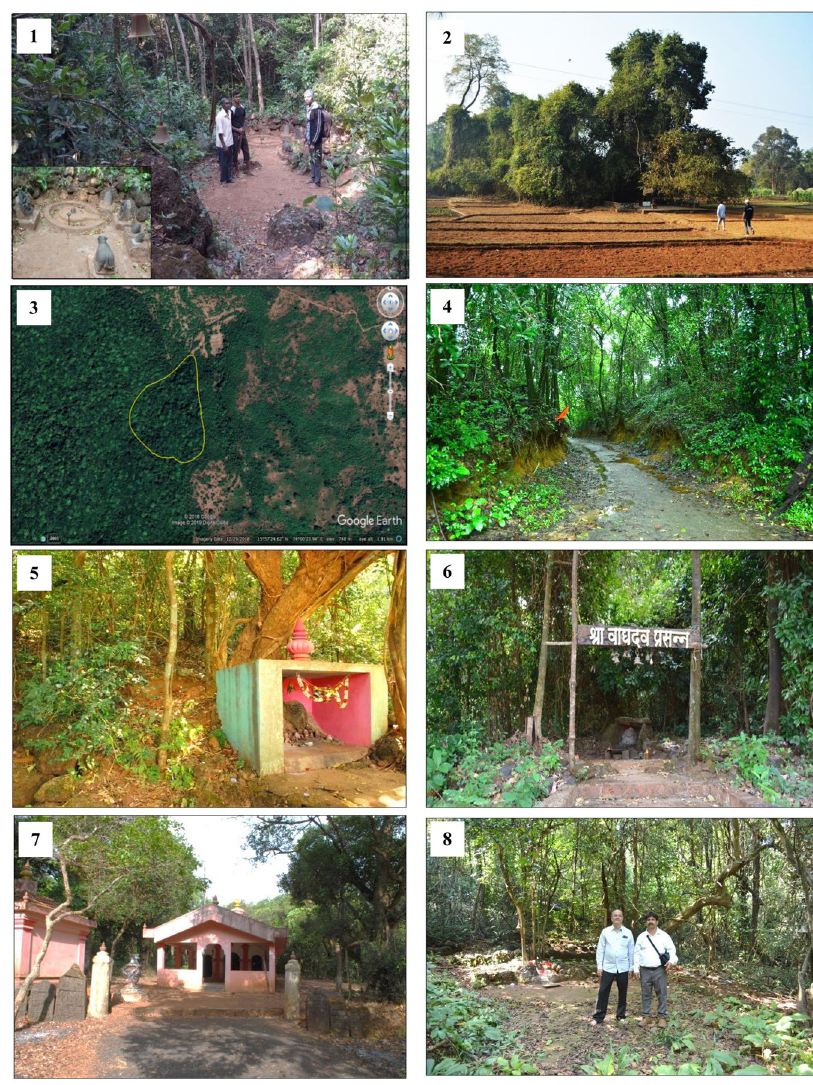
Fig. 2 Representative Sacred Groves from the Study